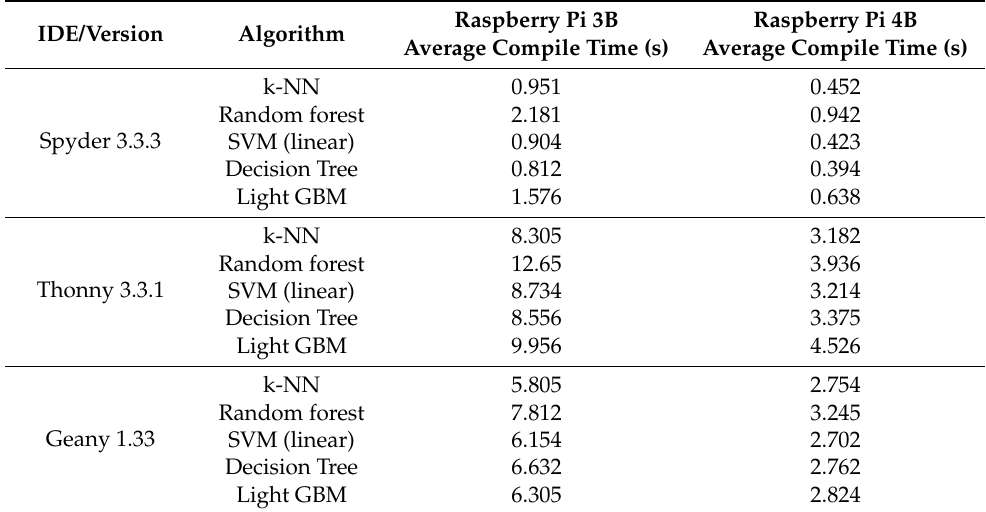
Table 3. Average compile time on popular Python IDEs.